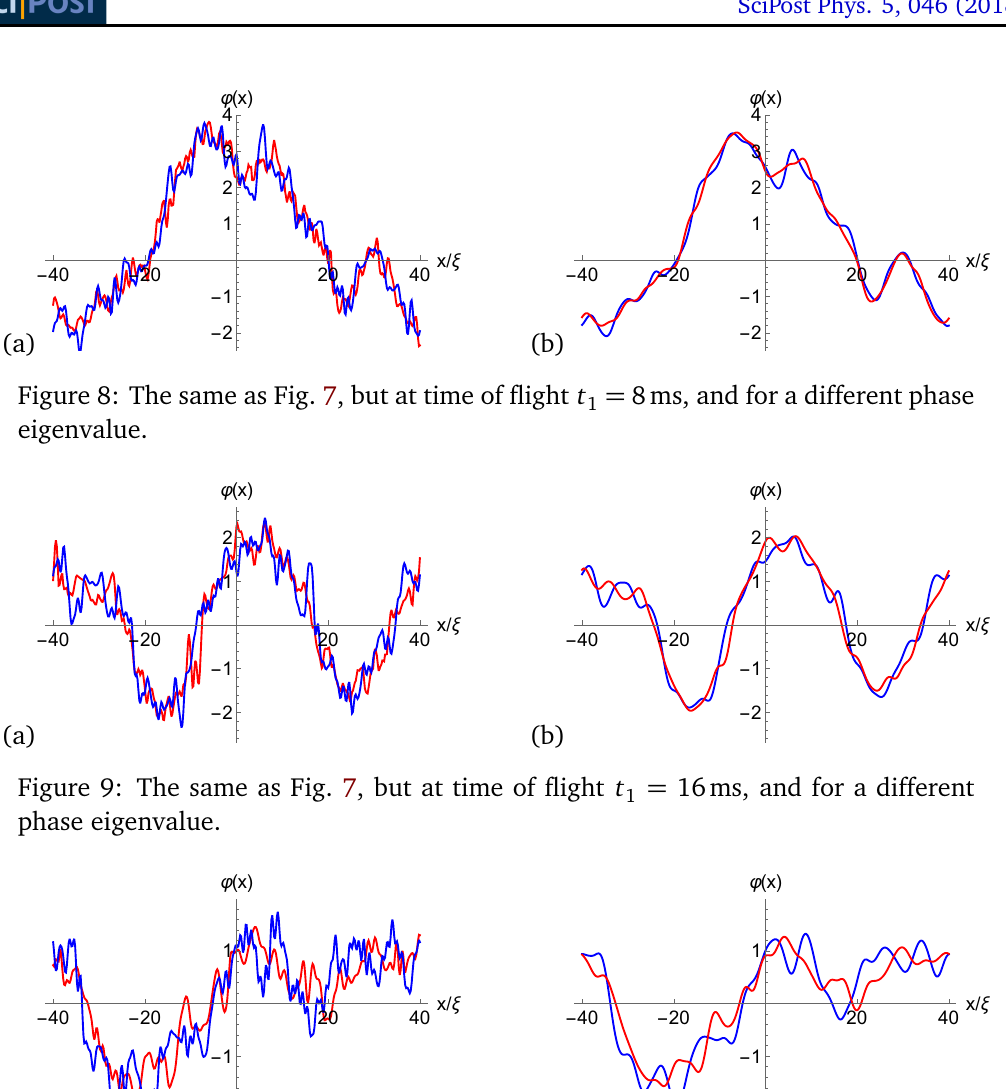
Figure 10: The same as Fig. 7, but at time of flight t phase